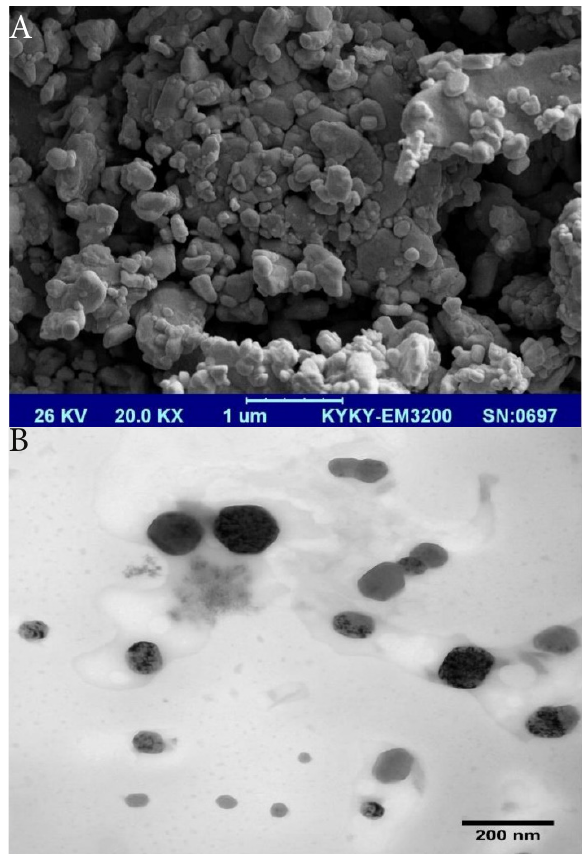
Figure 1. SEM image (A) and TEM image of FeSO